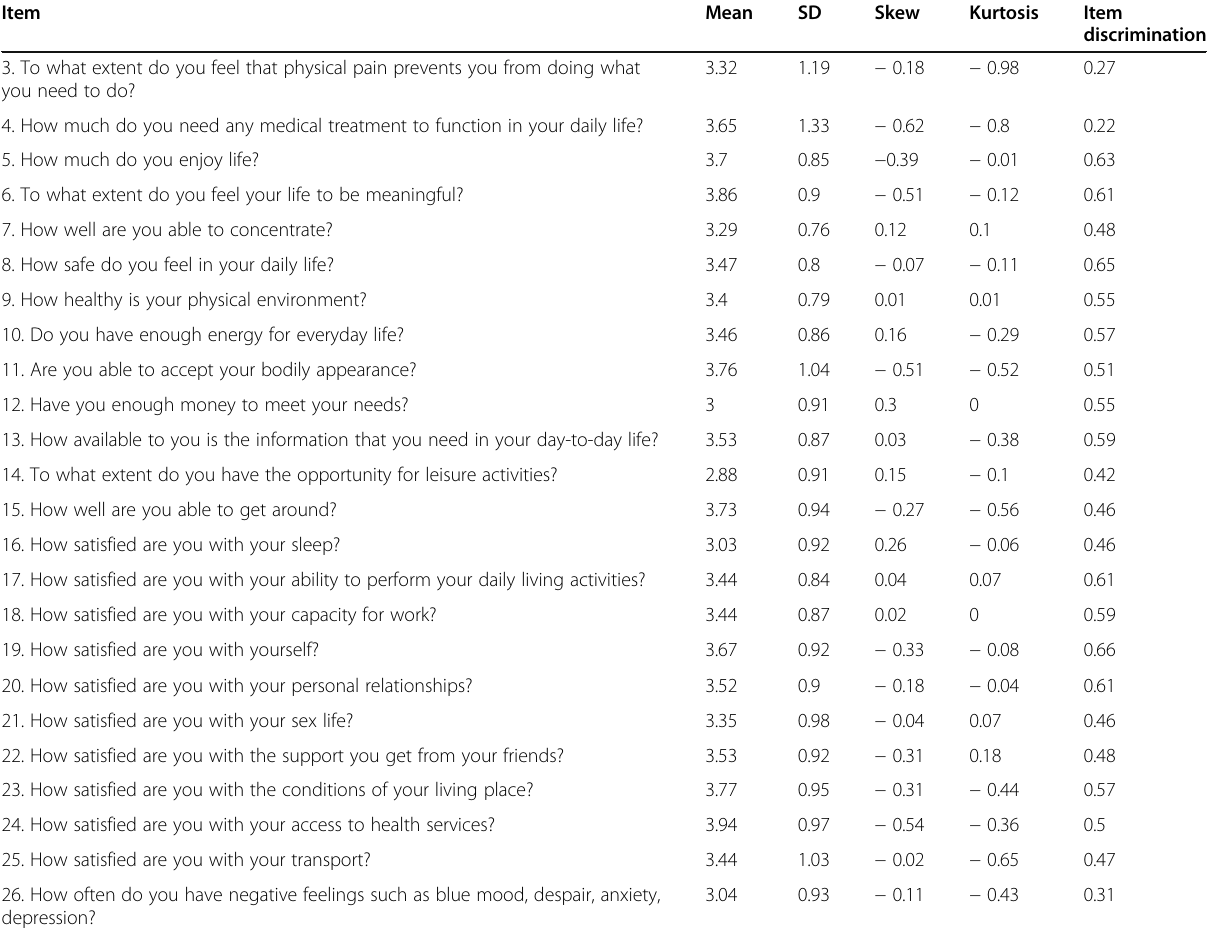
Table 2 Descriptive statistics of the items of WHOQOL-BREF